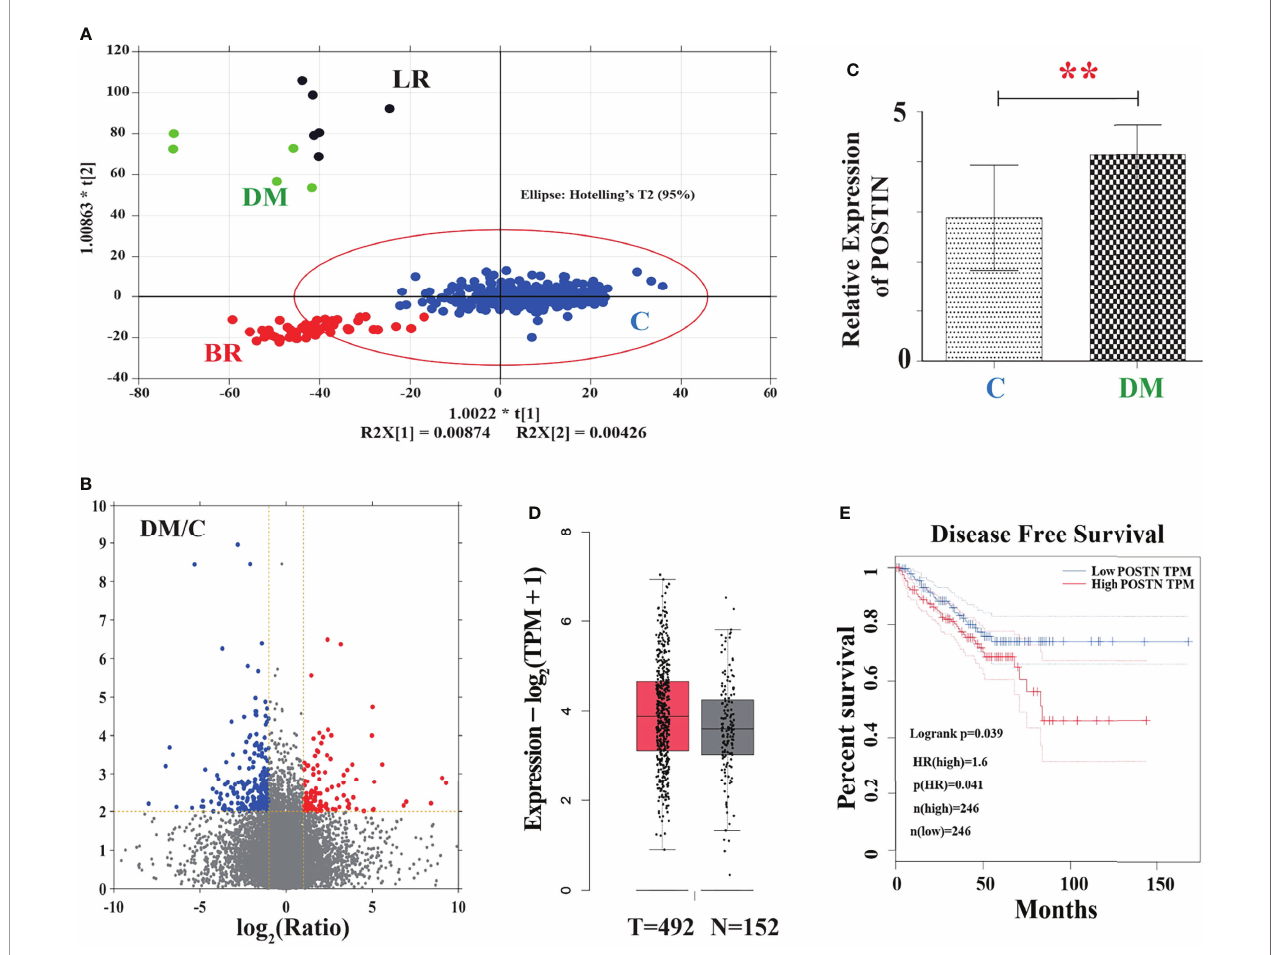
FIGURE 1 | The association between POSTN and metastasis in PCa was veri fi ed by the TGCA database. (A) The outcome of OPLS-DA. C, control; LR, local recurrence; BR, biochemical recurrence; DM, distant metastases. In this fi gure, the points inside the red line spheroid means a least signi fi cant difference test at a 95% con fi dence level. (B) Volcano plot showing differentially expressed proteins. Red color represents a high relative expression level; blue color represents a low relative expression level. (C) Relative mRNA expression of POSTN in the DM group vs. control group. ** p < 0.01. (D) POSTN expression between normal and patients veri fi ed by the Oncomine database. (E) Survival curve analysis of disease-free survival (DFS). DFS time between higher-expression level and lower- expression level of POSTN in PCa. Red line displays the cases with highly expressed POSTN, and blue line reveals the cases with lowly expressed POSTN. HR, hazard ratio. p (HR) =